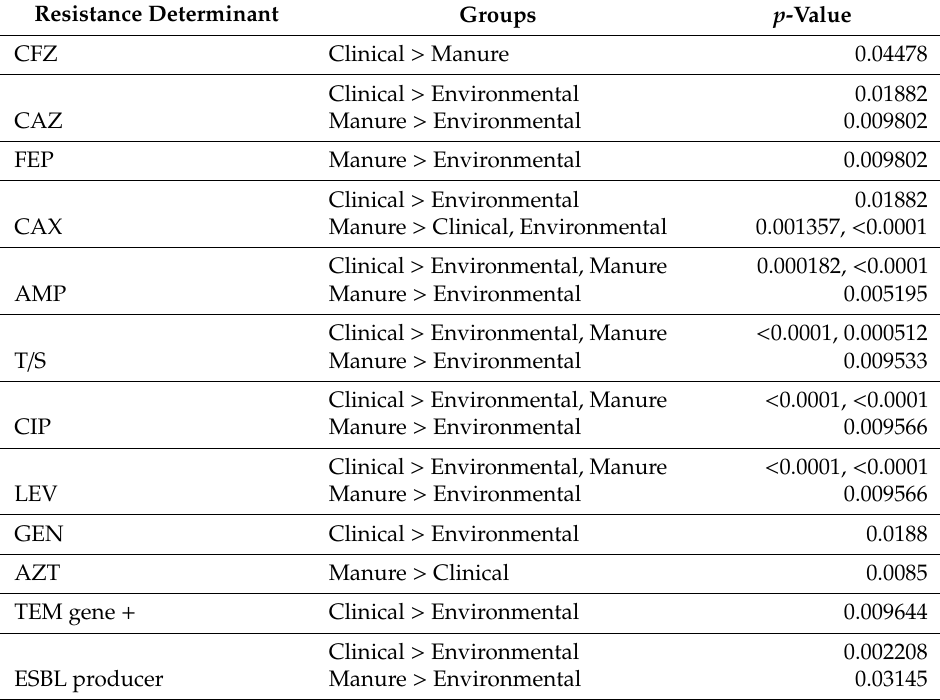
Table 1. Significant di ff erences in resistance determinant (phenotypic resistance, gene presence, and extended spectrum beta-lactamase (ESBL) production) between isolate source based on proportional Z